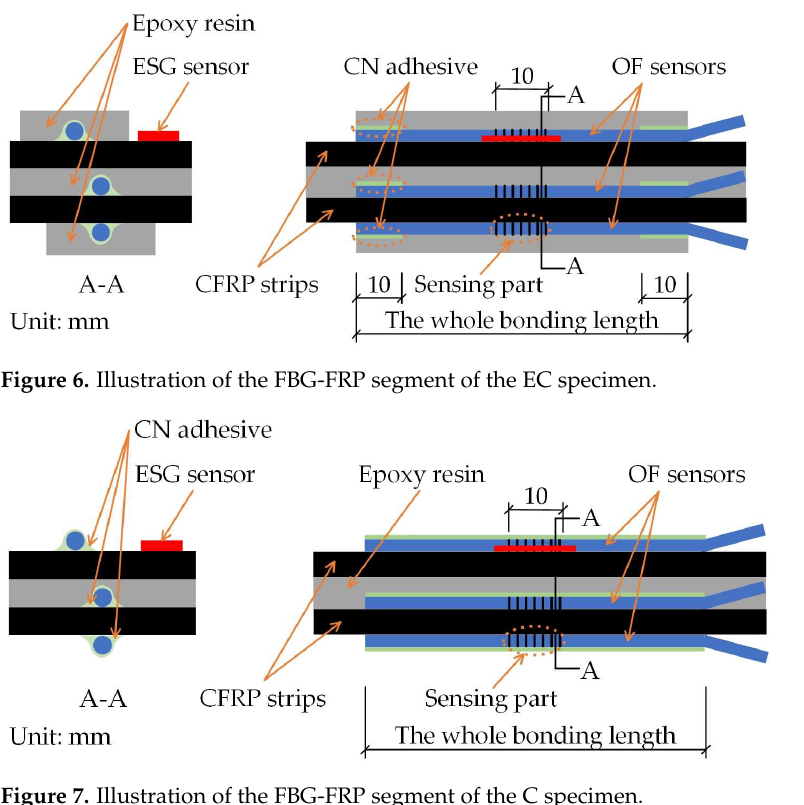
Figure 7. Illustration of the FBG-FRP segment of the C specimen.